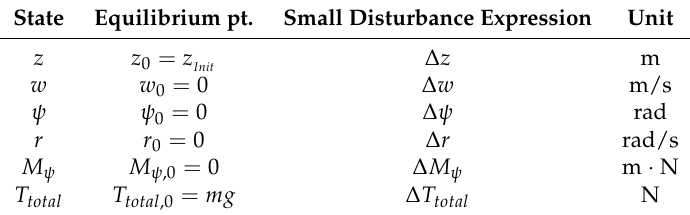
Table 2. Equilibrium pt. and small disturbance expression of each state and controls in vertical motion. State Equilibrium pt. Small Disturbance Expression